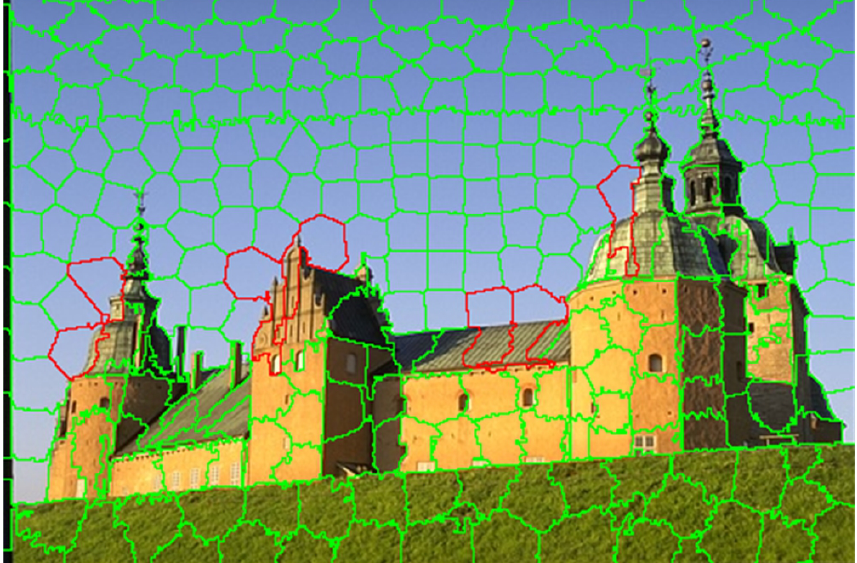
Figure 1. Mixed superpixels marked by red outline.